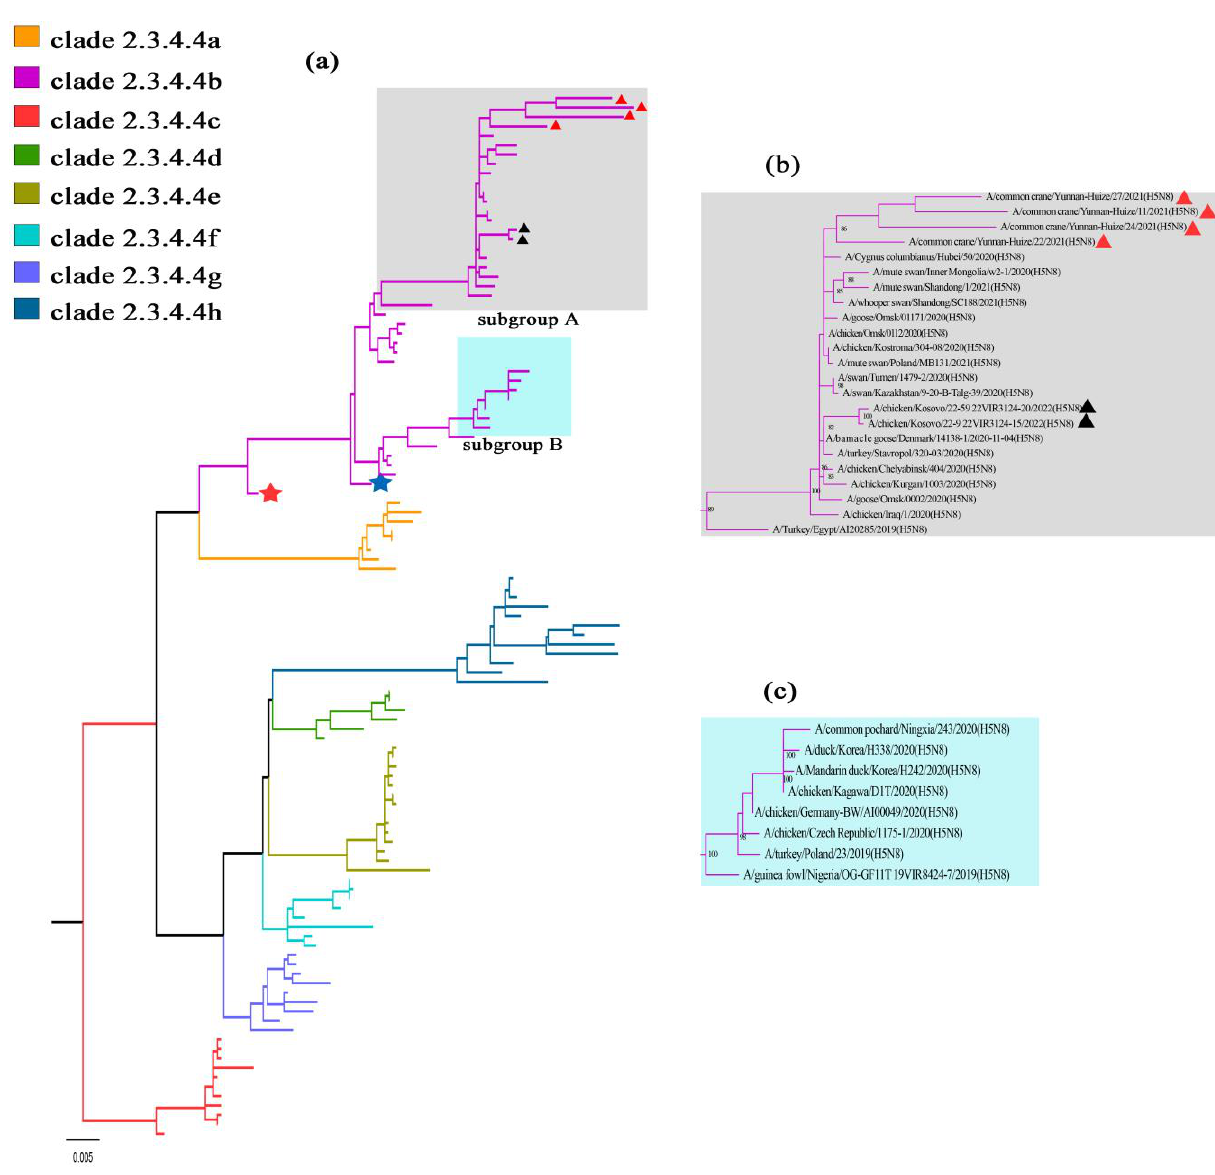
Figure 2. Maximum likelihood (ML) phylogenetic tree of the HA gene segment of the H5N8 AIVs. ( a ) Viruses in clade 2.3.4.4a-h are denoted by different colors and two subgroups (subgroup A and B) clustered in clade 2.3.4.4b are marked by different shades of grey and green. The strain marked with a red asterisk was the representative isolation (A/broiler duck/Korea/Gochang1/2014) of the first H5N8 outbreak wave in 2014, and the strain marked with a blue asterisk was the representative isolation (A/Bar-headed Goose/Qinghai/BTY1-B/2016) of the second H5N8 outbreak wave in 2016. ( b ) Subgroup A clusters the H5N8 HPAIVs derived from the ancestral strain of A/Tur- key/Egypt/AI20285/2019. The H5N8 HPAIVs from common crane in this study (labelled with a red triangle) and the strains isolated in 2022 (labelled with a black triangle) are clustered in this sub- group. ( c ) Subgroup B clusters the H5N8 HPAIVs derived from the ancestral strain of A/guinea fowl/Nigeria/OG-GF11T_19VIR8724-7. Branch supports were assessed with 1000 bootstrap repli- cates and only values higher than 70% are shown at the branch nodes. The MCC trees of the eight gene segments showed the same genetic topologies with the ML trees (Figures 3 and S1). The timing of the emergence of the strains was estimated in the time-scaled phylogenetic trees by molecular clock analysis. The results indicated that the median tMRCA for the individual gene segments of the H5N8 isolates from common cranes in Yunnan Province, China, ranged from April 2020 ( HA segment) to October 2020